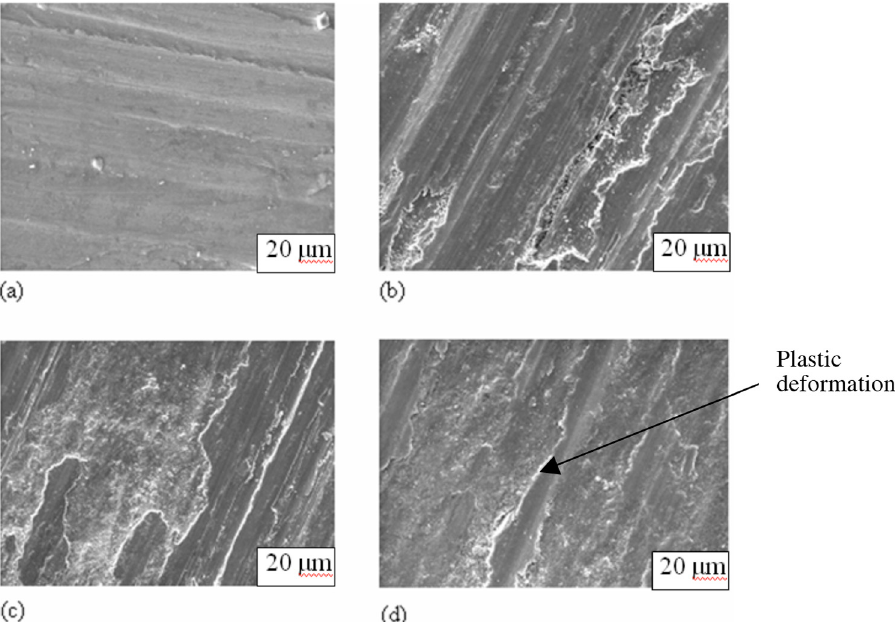
Fig. 4. SEM micrographs of the worn surfaces of (a) LM25 (b) LM25+5% SiC (c) LM25+ 3% Cu (d) LM25+5%SiC+3%Cu at Load (cid:2) 30 N, Sliding speed (cid:2) 2.4m/s and Sliding distance (cid:2) 1000